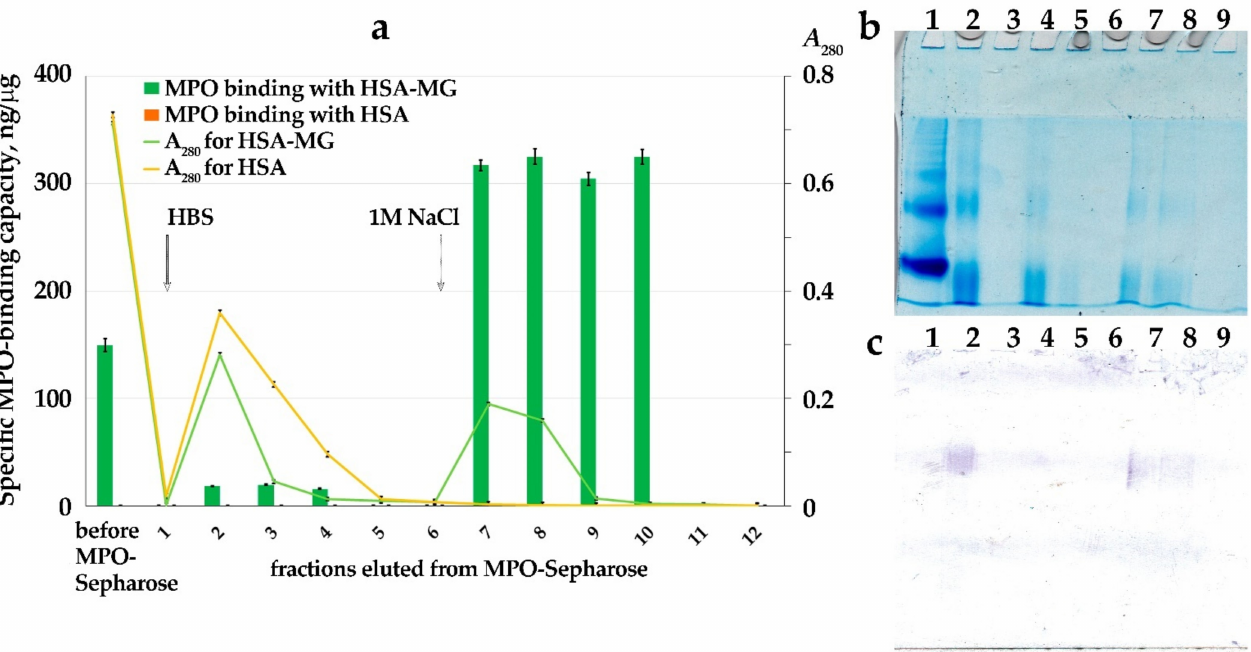
Figure 3. Analysis of fractions obtained by affinity chromatography of 1 mL 10 µ M HSA or HSA-MG on MPO–Sepharose. ( a ) Profile of elution ( A 280 ) and specific MPO-binding capacity of protein in fractions. Start of elution by HBS (fractions 1–6) and by 1 M NaCl (fractions 7–12) marked by arrows ( n = 3). ( b ) Resolution of proteins by disc-electrophoresis in polyacrylamide gel without detergents of 20 µ L samples of loaded protein HSA (1), HSA-MG (2), fractions 1–4 (3–6) and 7–9 (7–9) of HSA-MG. Stained by protein-specific dye—Coomassie G-250. ( c ) Ligand Western blotting assay of same gel (as in ( b )) after incubation with 1 µ g/mL MPO, 300 ng/mL HRP-1#8 (anti-MPO), followed by 4-CN with H 2 O 2